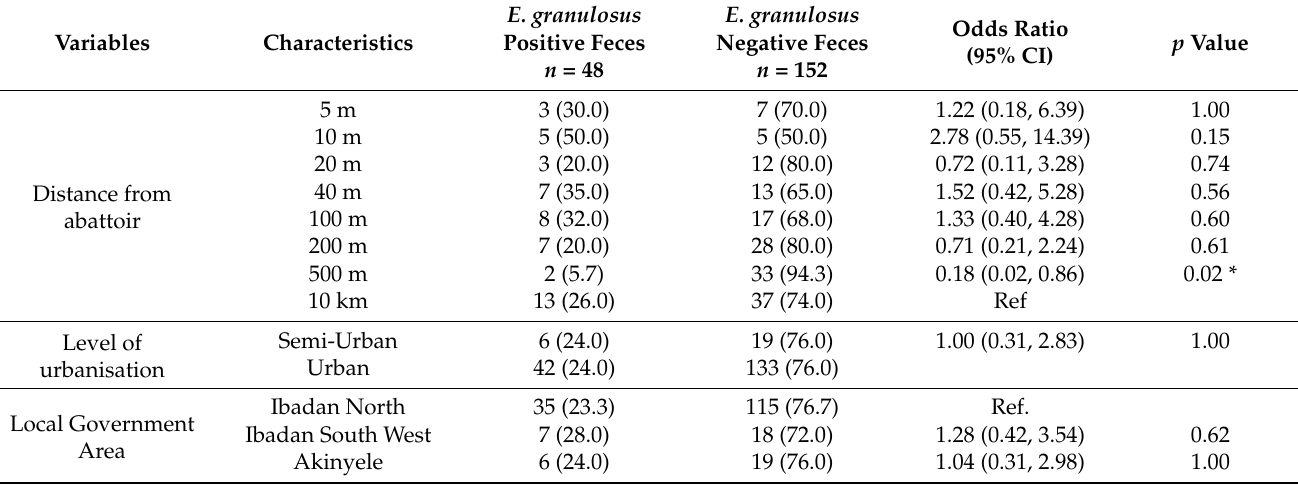
Table 2. Environmental factors associated with E. granulosus s.l. presence in fecal samples ( n = 200) from stray dogs in